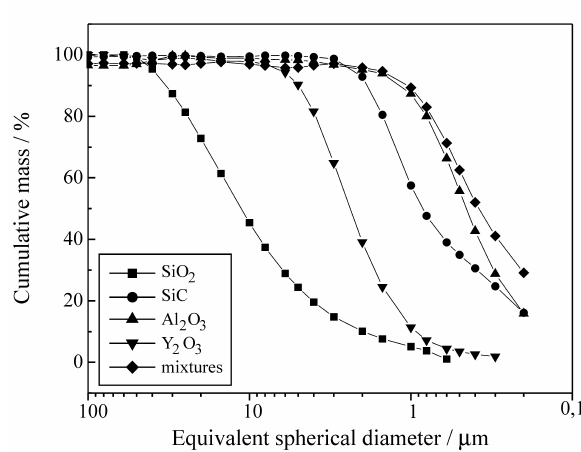
Fi gu re 2. Par ti cle/ag glo me ra te size dis tri bu ti on of pow der and a typi - cal mix tu re (60-20Y).